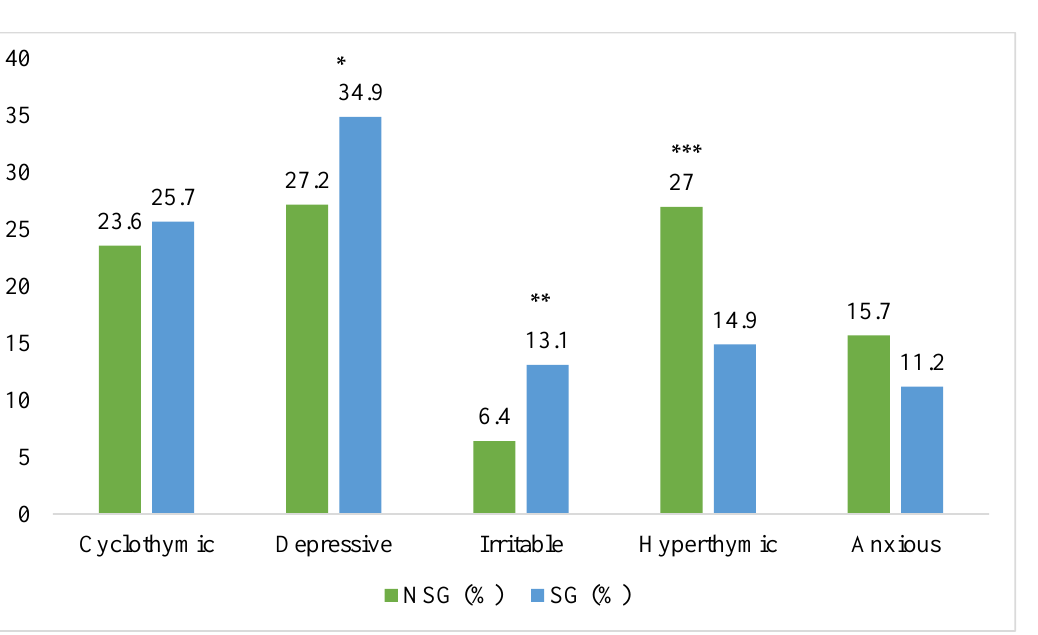
Figure 3. Number of suicide attempts according to dominant affective temperament. * p < 0.05, ** p < 0.001. Patients with trait-related impulsiveness presented a higher number of suicide at- tempts (1.29 vs. 0.67 in the rest of the sample, p < 0.0001) and a more frequently impaired psychosocial functioning (1.23 vs. 0.56 in the rest of the sample; p < 0.001).